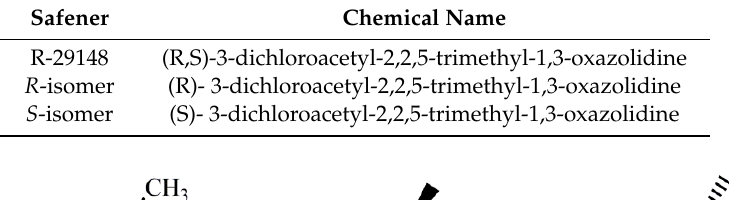
Table 5. Chemical names of tested safeners.